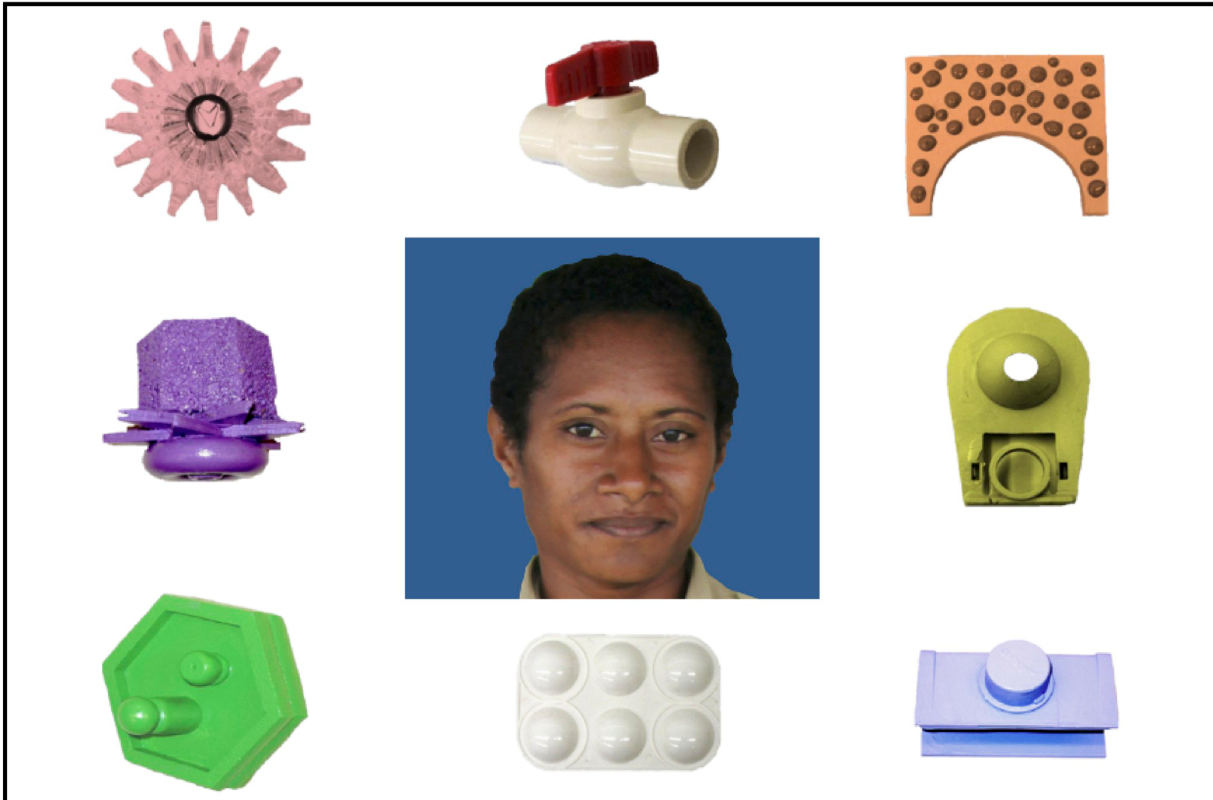
Fig 5. Example of the familiarization slide for Experiment